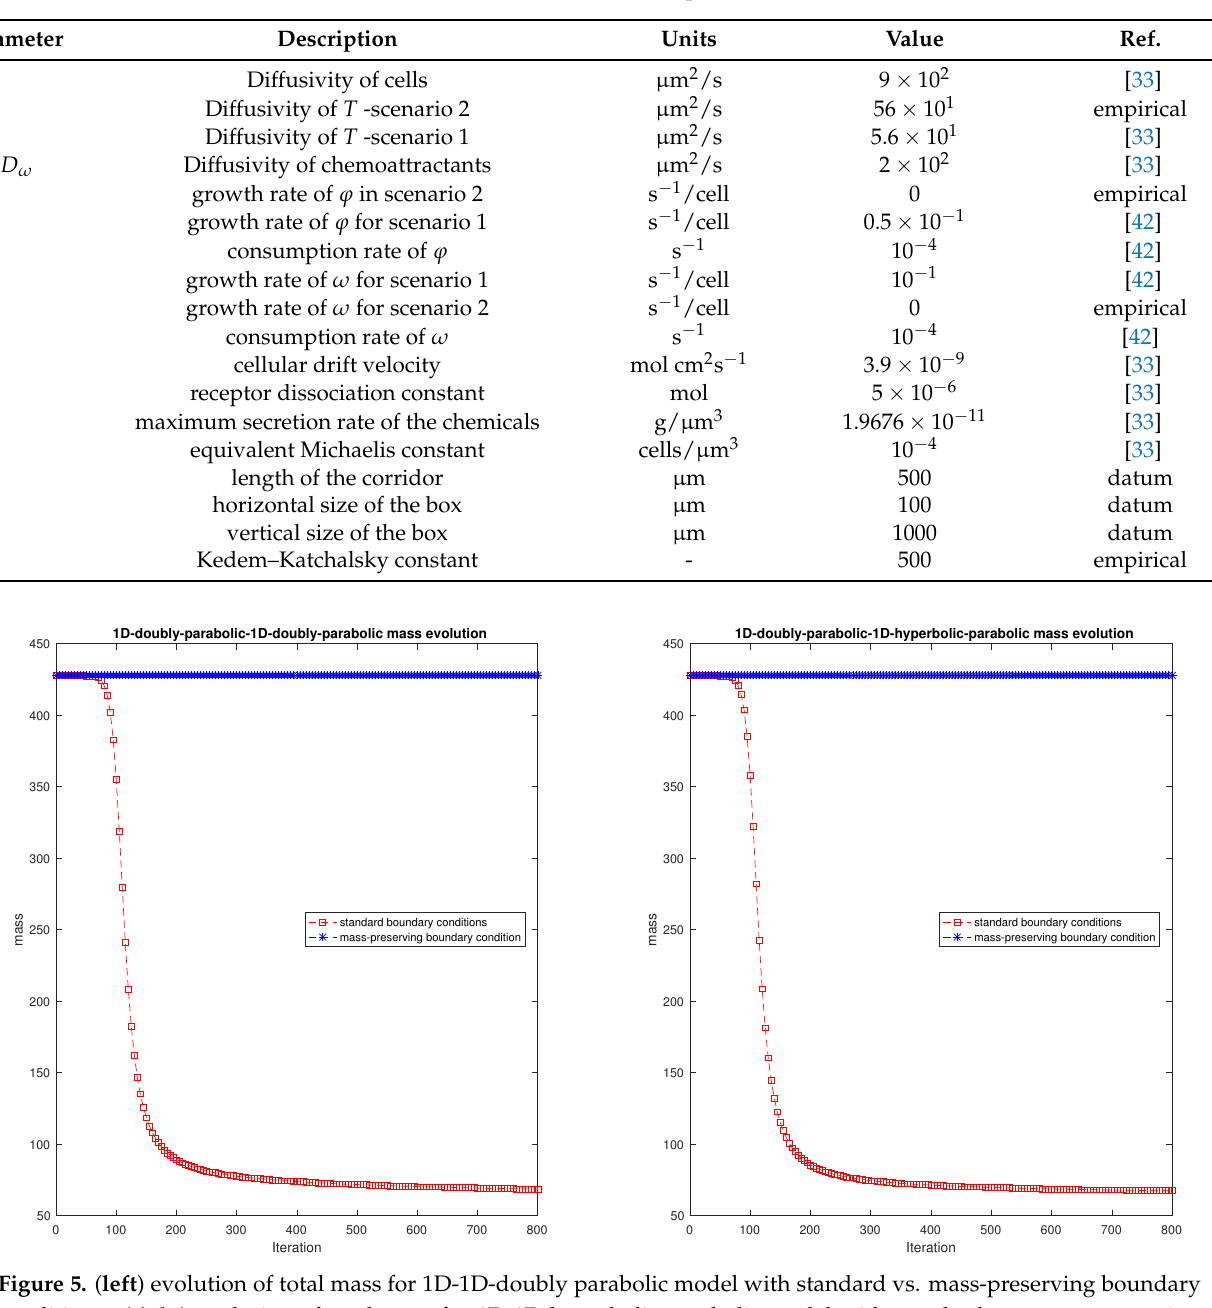
Table 1. Parameters of the problem.